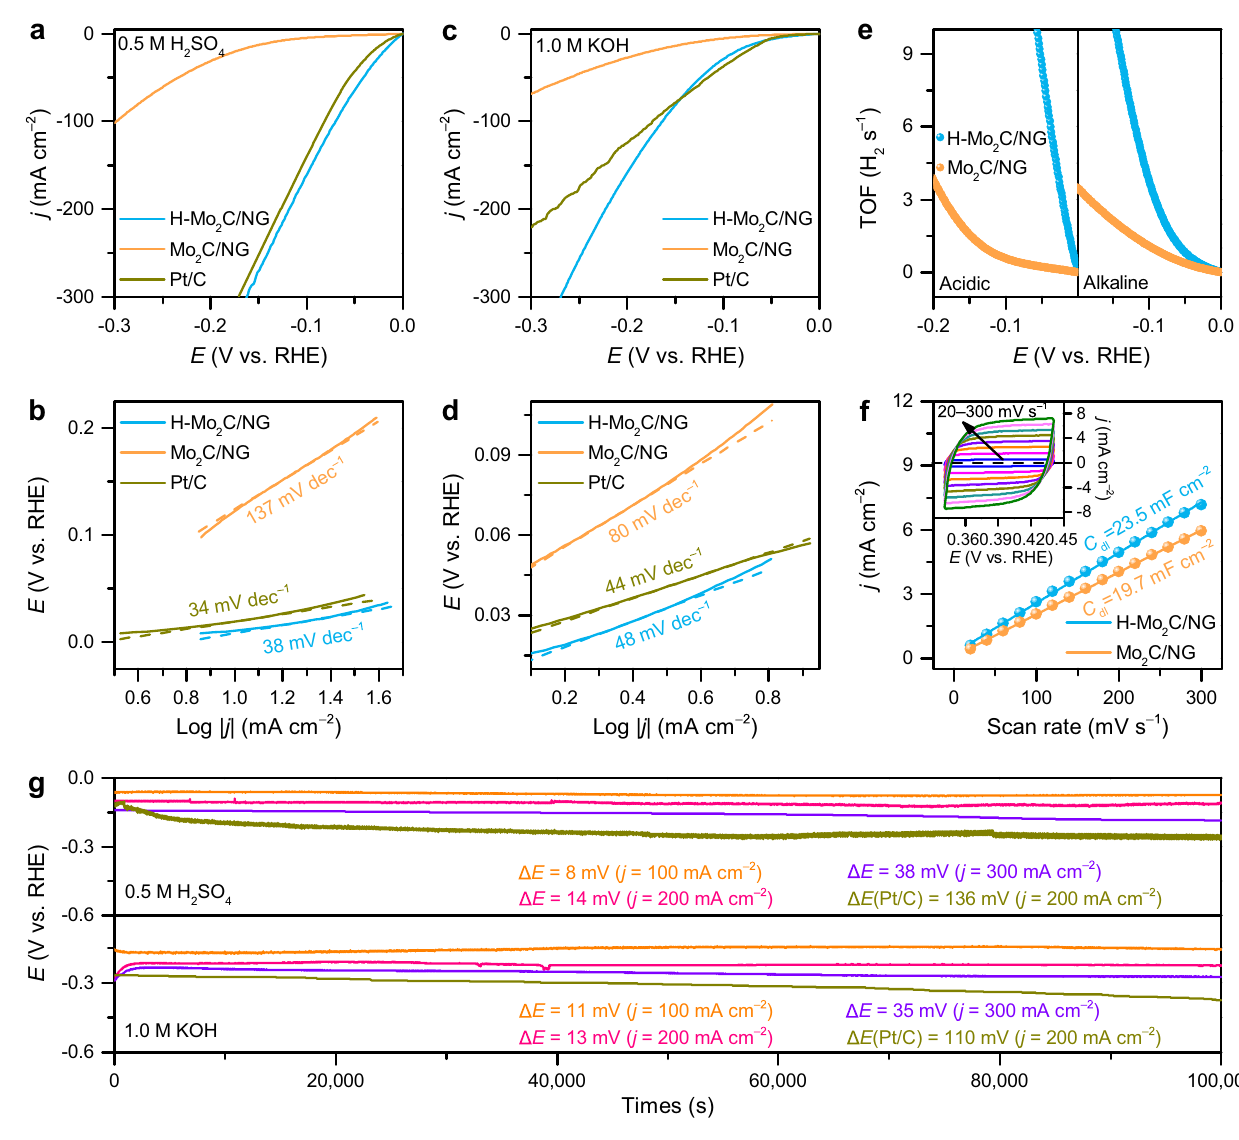
Fig. 5 | HER performance. a , c The polarization curves and b , d the relevant Tafel plots of H-Mo 2 C/NG, Mo 2 C/NG, and Pt/C in a , b 0.5M H 2 SO 4 and c , d 1.0M KOH, respectively. e TOF values of H-Mo 2 C/NG and Mo 2 C/NG in 0.5M H 2 SO 4 and 1.0M KOH. f The plots of the current density versus the scan rate for H-Mo 2 C/NG and calculatedtobe5.47mAcm − 2 ,whichismuchhigherthanthatofMo 2 C/